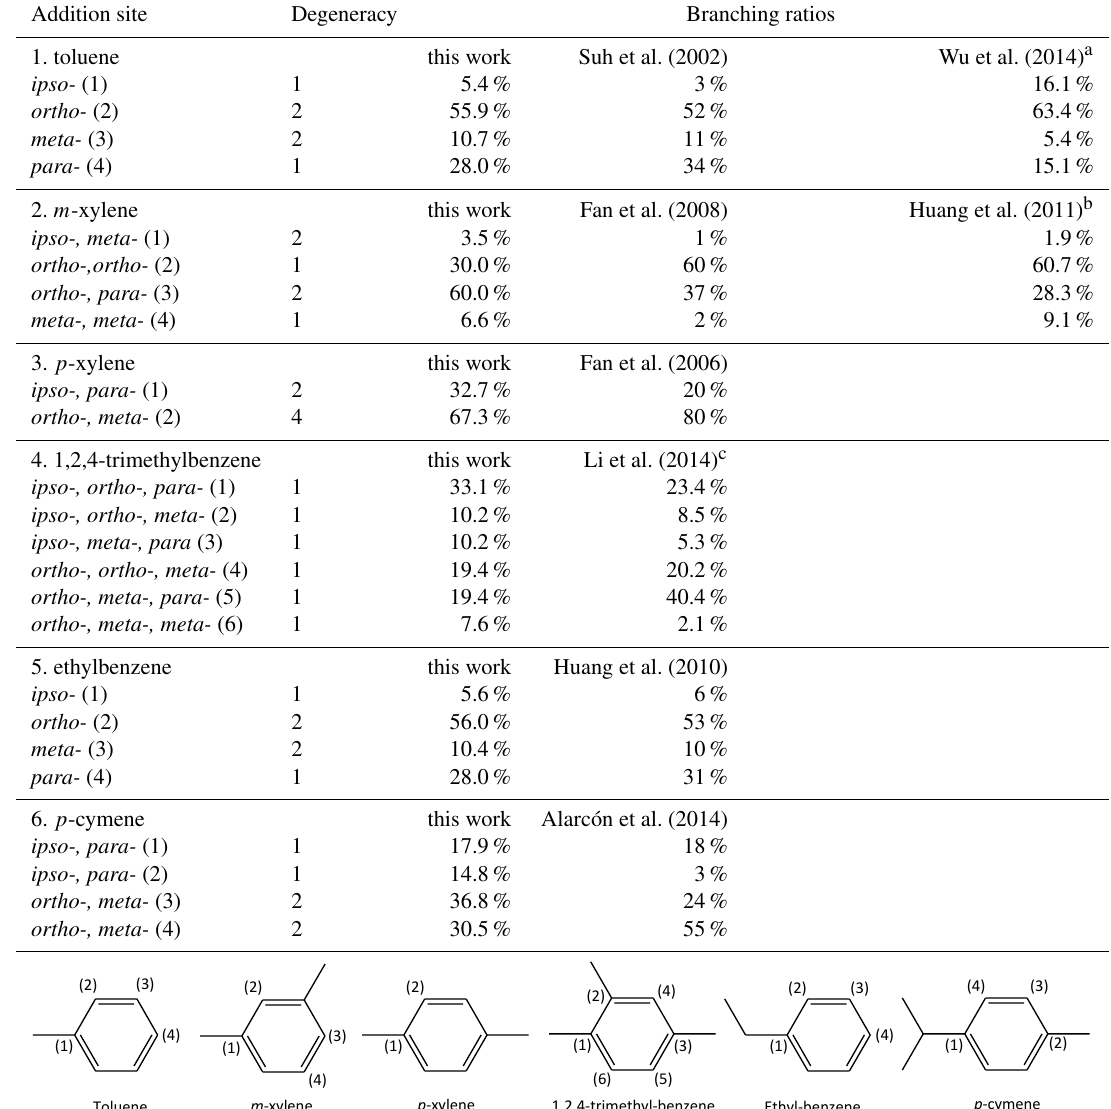
Table 5. Comparison of estimated branching ratios for OH addition to alkyl-substituted aromatic hydrocarbons at 298K with those reported in density functional theory (DFT) studies. Displayed values are presented relative to k add